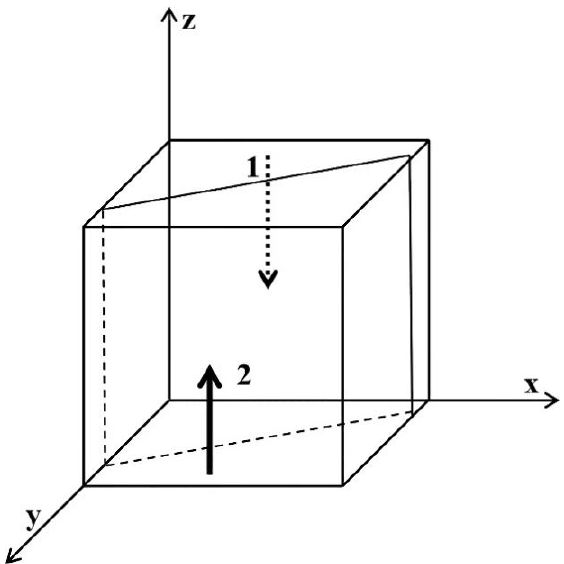
x x Figure 5. Influence of on the evolutionary equilibrium stable strategy of Figure 5. Influence of on the evolutionary equilibrium stable strategy of Figure 5. Influence of x on the evolutionary equilibrium stable strategy of z . Region 1 is using regular using regular masks; region 2 is using EFMs. using regular masks; region 2 is using EFMs. masks; region 2 is using EFMs.